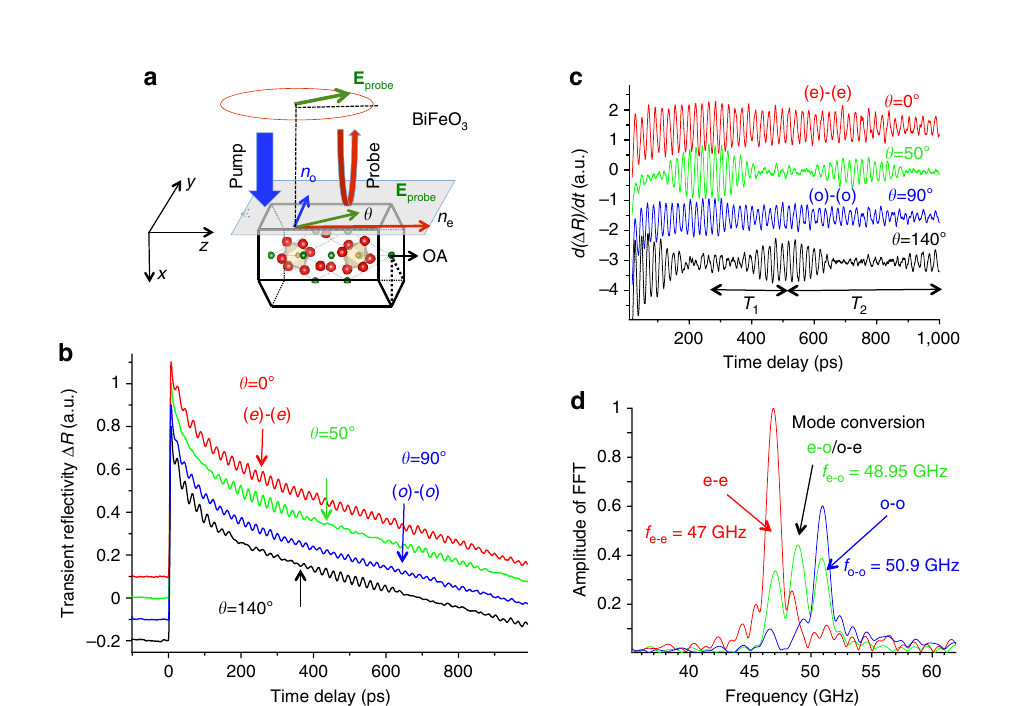
Figure 2 | Ultrafast acousto-optic mode conversion in BFO. ( a ) sketch of the pump–probe experiment carried out on BFO with OA along the z axis. The time-resolved Brillouin process is investigated with the probe beam with a variable polarization ( E probe ). ( b ) Typical transient reflectivity signal with variable linear probe polarization in ferroelectric (BFO). ( c ) Time derivatives of the transient optical signals. T 1 and T 2 are the beating periods coming from the interferences of the three Brillouin modes (o-o), (e-o)/(o-e) and (e-e). ( d ) FFTs of the signals revealing the (o)-(o) and (e)-(e) processes but also the mode-conversion processes ((e)-(o) and (o)-(e)). The frequencies corresponding to o-o and e-e processes are in full agreement with the expected values and the Brillouin frequency corresponding to the (e)-(o)/(o)-(e) process is exactly centred between the Brillouin frequencies (o)-(o) and (e)-(e) as predicted by the